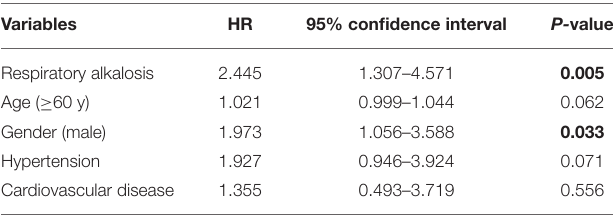
TABLE 3 | Multivariate Cox regression analysis for severe events of adult COVID-19 patients.